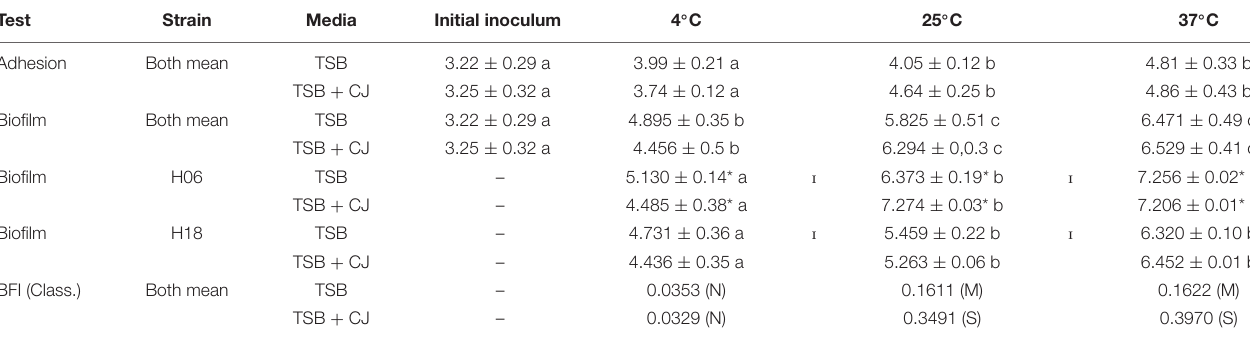
TABLE 4 | Mean counts (Log CFU/mL) and BFI (Biofilm Formation Index) obtained in the tests for the two strains of S H under different temperature conditions.